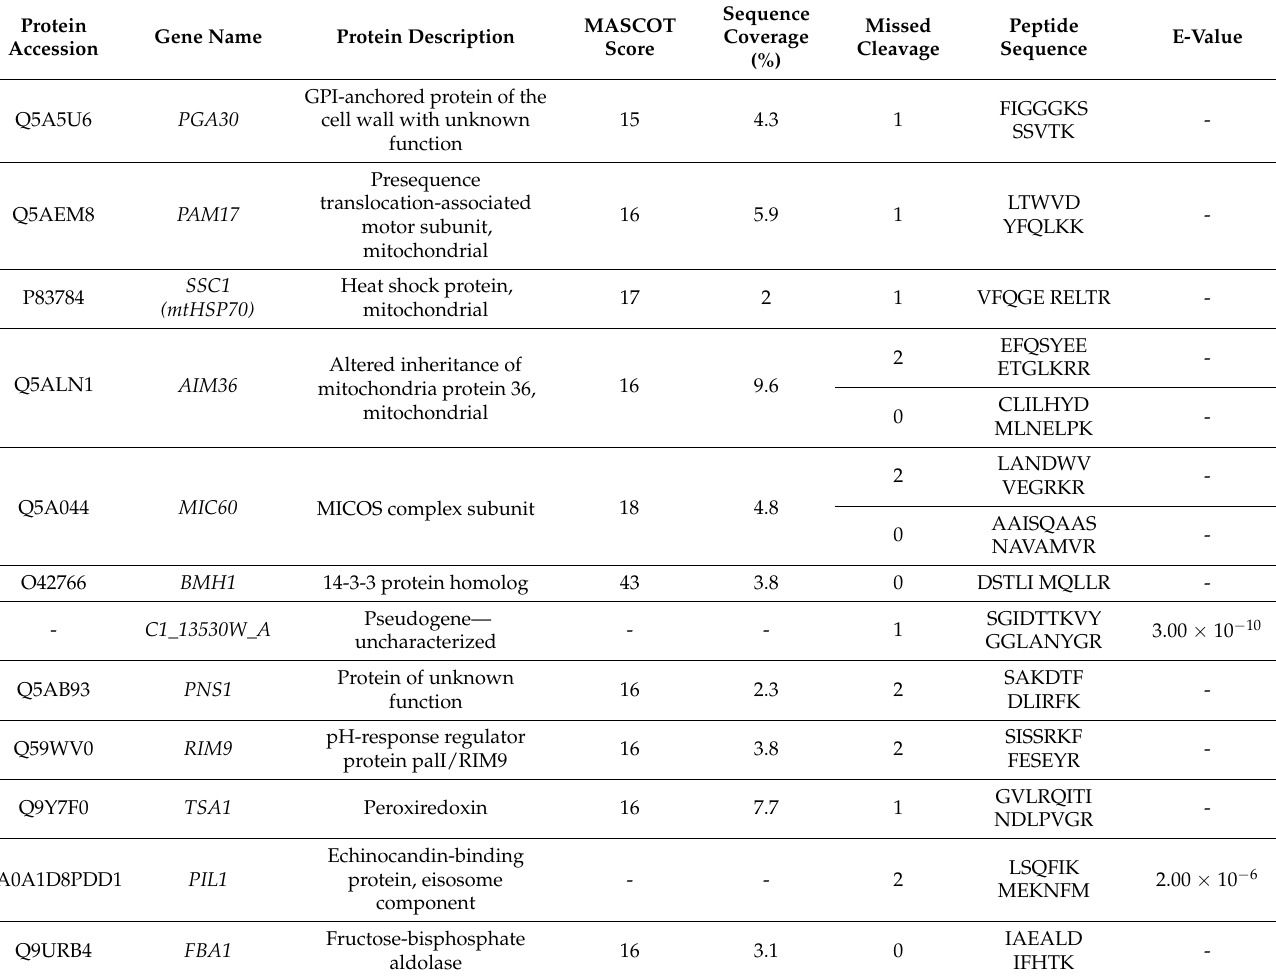
Table 7. Proteins involved in other functions were identified in the fluconazole-resistant C. albicans strain. Proteins identified using MASCOT are represented with sequence coverage while proteins identified using BLAST are represented with